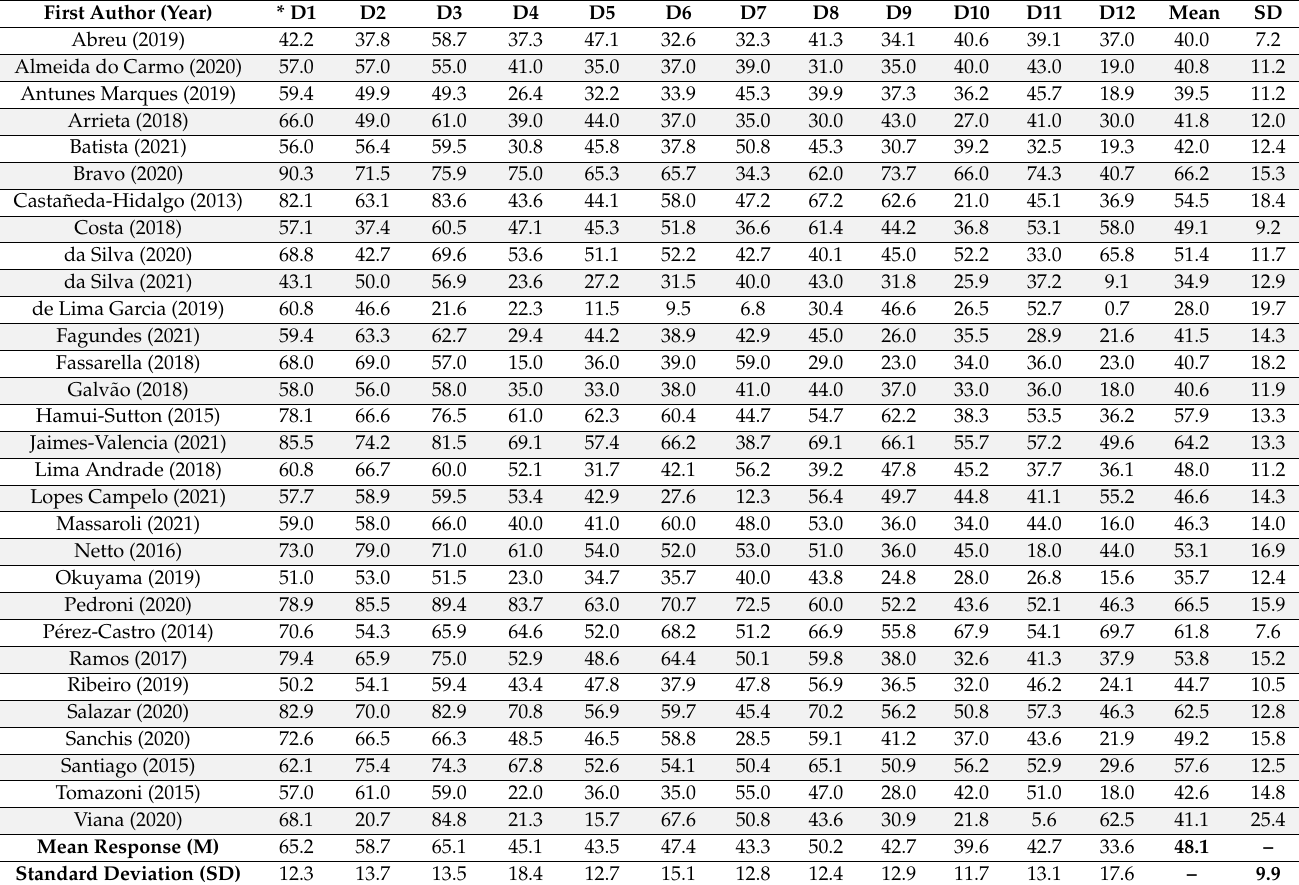
Table 2. The positive responses for patient safety culture dimensions by study (n =